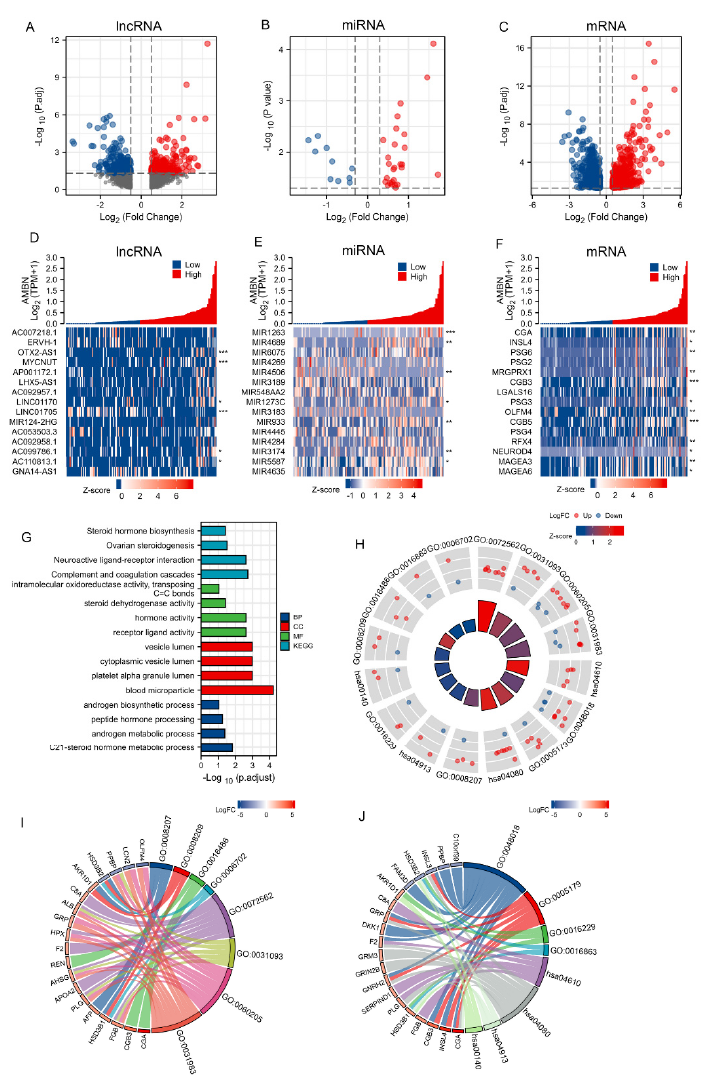
Figure 2. Differential expression gene analysis between AMBN high and AMBN low expression in TGCT samples Volcano plot ( A – C ) and heat map ( D – F ) for DElncRNAs (adj p < 0.05 and |FC| > 0.5), DEmiRNAs ( p < 0.05 and |logFC| > 0.3) and DEmRNAs (adj p < 0.05 and |logFC| > 0.5) (z-score indicates the expression level of the factor of interest in the corresponding sample, and * indicates the correlation between the factor of interest and AMBN). ( G – J ) GO and KEGG analysis of Differential expression gene (BP for Biological Process, MF for Molecular Function, and CC for Cellular Component, the logFC-score indicates the expression level at the factor of interest, *, p < 0.05; **, p < 0.01; ***, p < 0.001). The symbols and |logFC| of all DEGs were used to perform GO, KEGG and